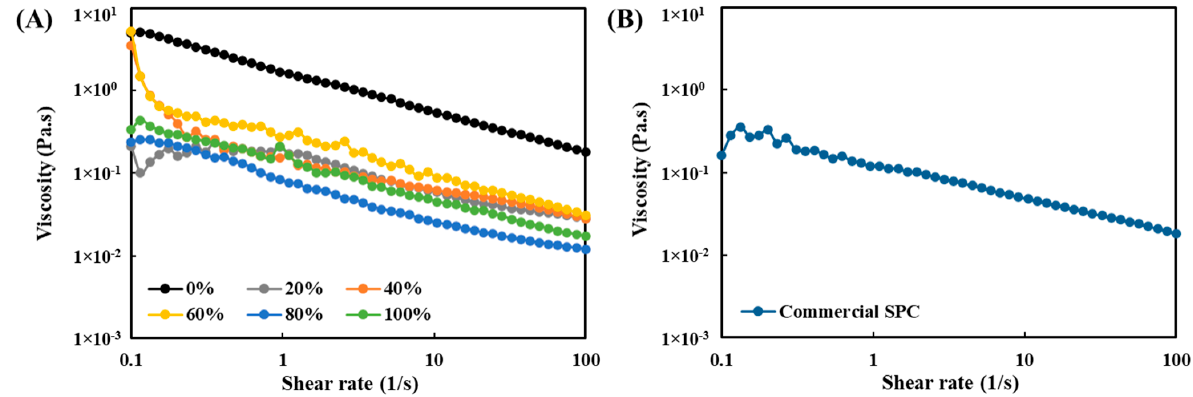
Figure 9. Viscosity as a function of shear rate at 25 ◦ C of ( A ) aqueous ethanol-washed soy protein concentrates (SPCs); and ( B ) commercial SPC dispersions (standardized 6 wt% protein content). 3.9. Gelation Behaviors The gelation behaviors of the SPCs upon and after thermal treatment were studied with temperature, frequency, and strain sweep applications, and are shown in Figure 10. The protein concentrations for all the samples were standardized at 9 wt%, according to different protein contents in the SPCs (Table 1). For all the SPC samples, the storage mod- ule (G ′ ) values were constantly higher than loss module (G ″ ) values, even without heating. This indicated that a dispersion with 9 wt% protein concentration was able to form solid- like structures at room temperature. During the temperature sweep, similar G ′ and G ″ value changes were observed for all the SPC samples. Abrupt increases in the G ′ and G ″ values were found by heating the sample at a temperature range from 70 to 95 °C, which may have been caused by gel formation. During the constant temperature regime at 95 °C, the value of the G ′ increased somewhat, while the G ″ value was almost stable. After that, a slight decrease followed for both G ′ and G ″ . During cooling, the G ′ and G ″ values both increased significantly for all the SPCs, indicating that the gel structures were further improved by the formation of additional bonds [63]. The commercial SPC showed similar gelation behaviors under the same measurements. When considering the values of G ′ and G ″ obtained from different SPCs, the SPC processed with 0% ethanol had the highest val- ues before heating, which was similar to the finding of viscosity. However, for the SPCs processed with 80% and 100% water/ethanol ratios, the G ′ and G ″ values increased more pronounced than other SPCs upon heating and cooling. The final G ′ and G ″ values of these two SPC samples were comparable to the SPC processed with 0% ethanol after the tem- perature sweep. During the frequency sweep, the G ′ and G ″ values of all the SPCs were relatively constant over the frequency range of 0.1–10 Hz. The highest values were found for SPCs processed with 0%, 80%, and 100% water/ethanol ratios, which were in the range of 1000– 10,000 Pa, approximately 10 times higher as compared with SPCs processed with 40% and 60% ethanol. The high value of water-washed SPC may have been caused by the formation of lipid-protein complex after heating, since washing with water hardly remove any oil